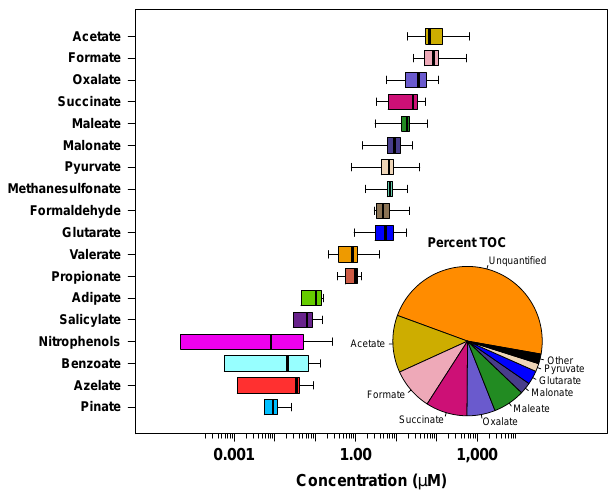
Figure 6. Concentrations of major carbonaceous components quan- tified in BYI fog samples. Box-and-whisker plot shows 25th and 75th percentiles with the median bar in the center, and whiskers at the min and max. Note that for C 1 –C 5 organic acids, n = 11; for formaldehyde, n = 10; and for components with C 6 or greater, n = 11. Pie chart (inset) shows carbonaceous composition as a per- centage of TOC (only those samples with results from all organic analyses included, n =